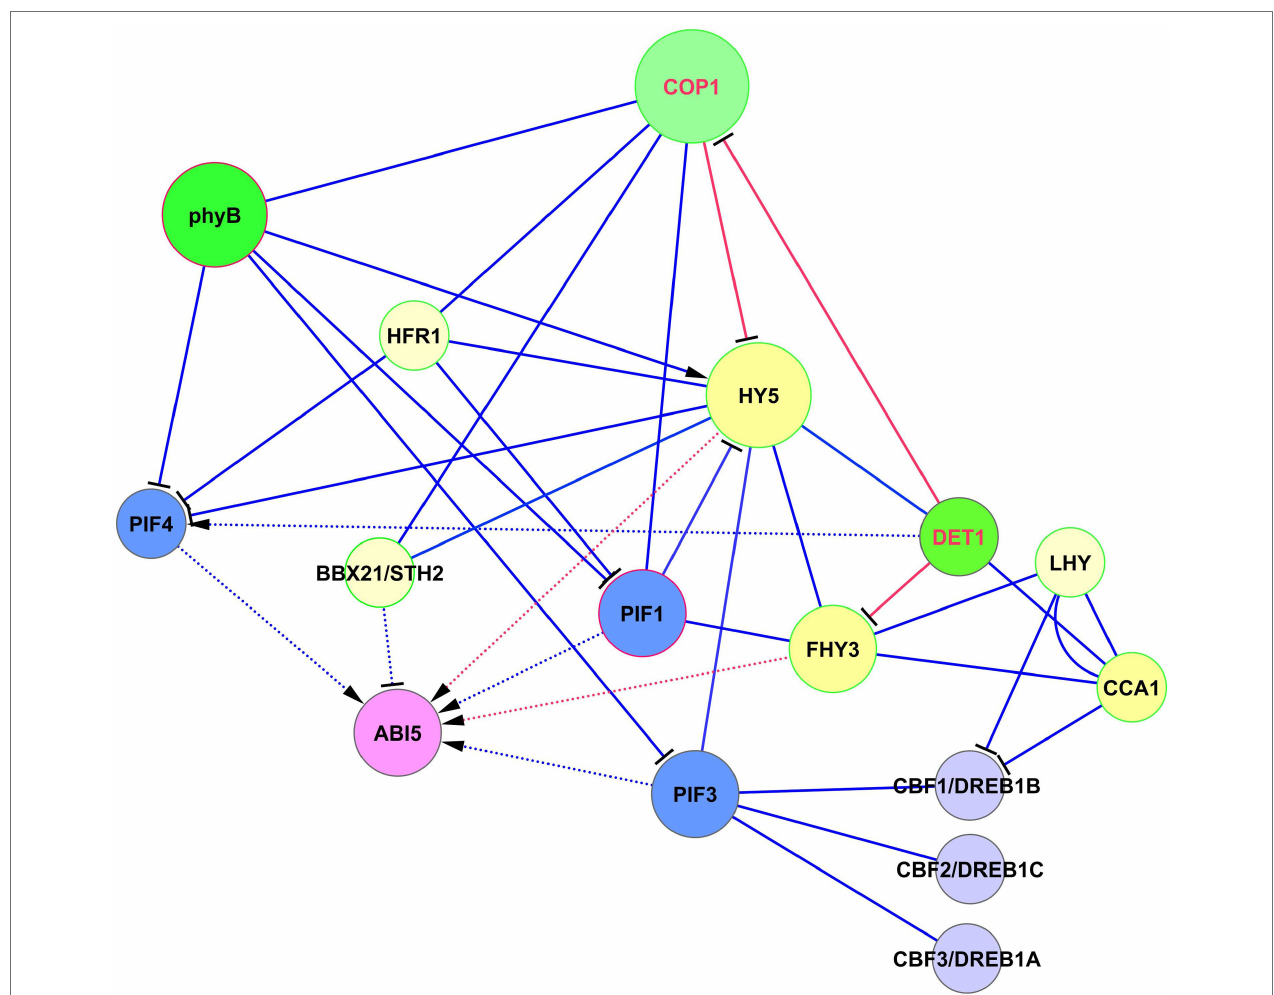
FIGURE 4 | Crossing of HY5, DET1, and FHY3 signaling with ABI5 function. ABI5 expression is regulated in two ways. The first one represents activation of ABI5 expression by HY5 by the DET1 — ‖ COP1 — ‖ HY5 → ABI5 module. The second level of regulation is realized by parallel pathway via DET1 — ‖ FHY3 → ABI5 and DET1/COP1 → PIF4 → ABI5 modules, where DET1/COP1 association promotes PIF4 expression and stabilizes PIF4 protein. DET1 also can form a complex with the CCA1/LHY module. Abbreviations: ABI5, ABA insensitive 5; phyA/B, phytochromes phyA and phyB; PIFs, phytochrome-interacting transcription factors; HY5, transcription factor HY5; FHY3, far-red elongated hypocotyls 3; BBX21, B-box zinc finger transcription factor BBX21; DET1, light-mediated development protein; CCA1, CCA1, circadian clock associated 1; LHY, late elongated hypocotyl; HFR1, transcription factor HFR1; COP1, E3 ubiquitin-protein ligase COP1; CBFs/ DREBs, dehydration-responsive element-binding